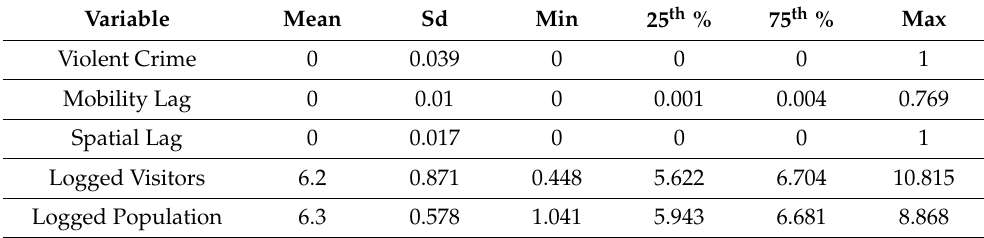
Table 1. Summary statistics for New York City.